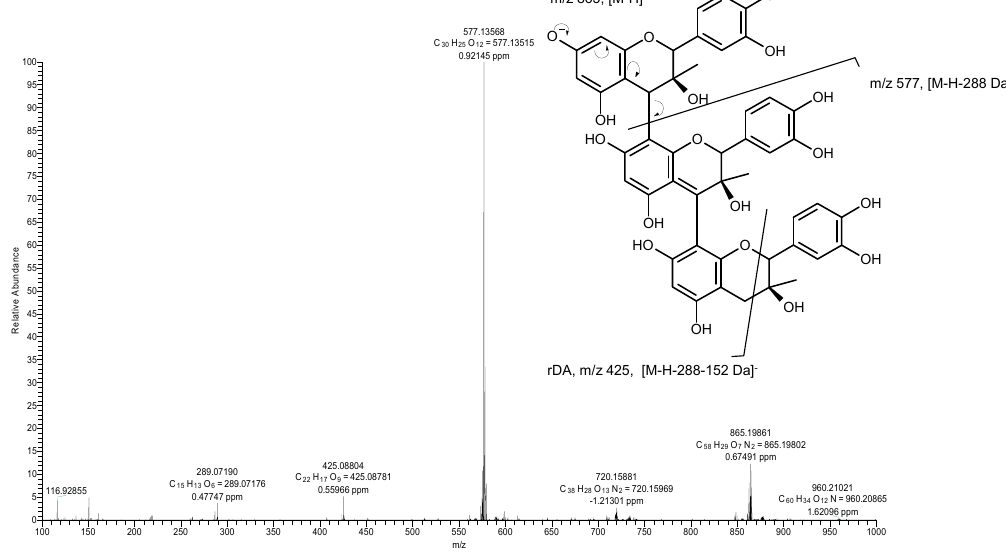
Figure 3. Mass spectrum and molecular structure of procyanidin trimer B-isomer 1 (compound 4) .